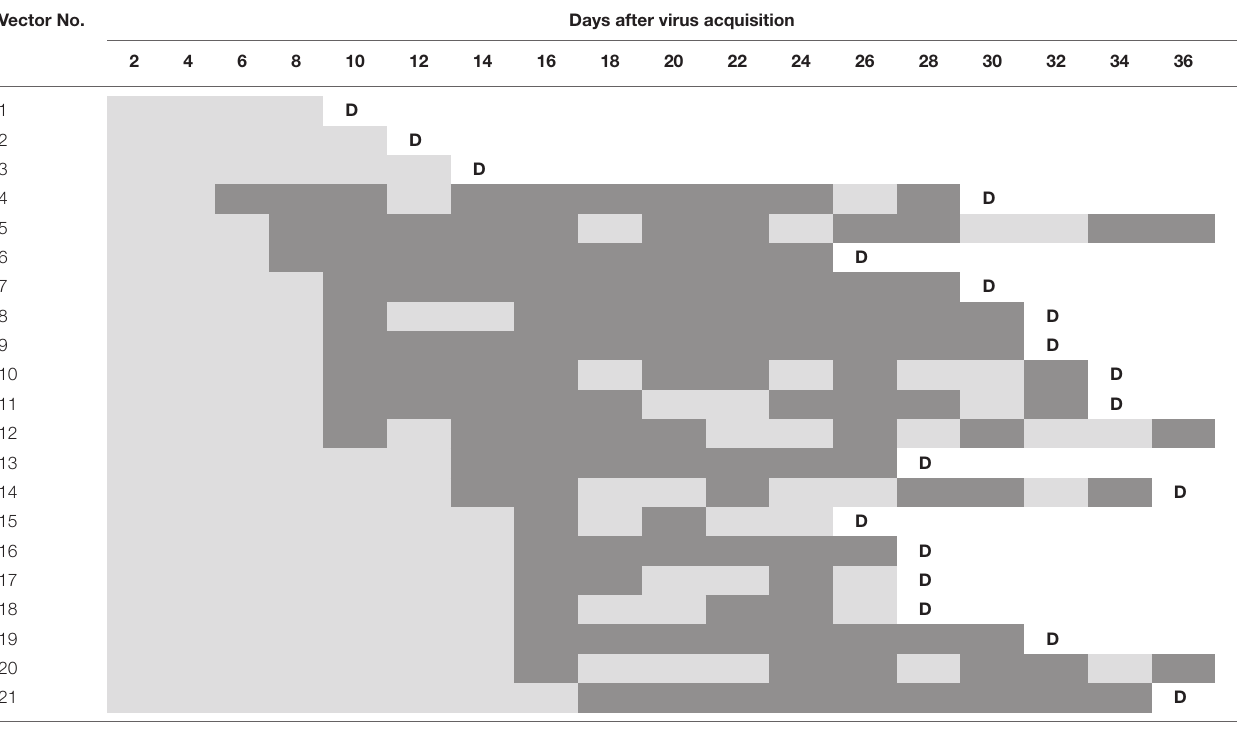
TABLE 3 | Latent period of RSMV in Recilia dorsalis . Vector